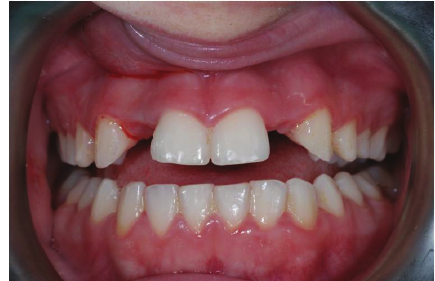
Figure 3: Flap incision in site to the